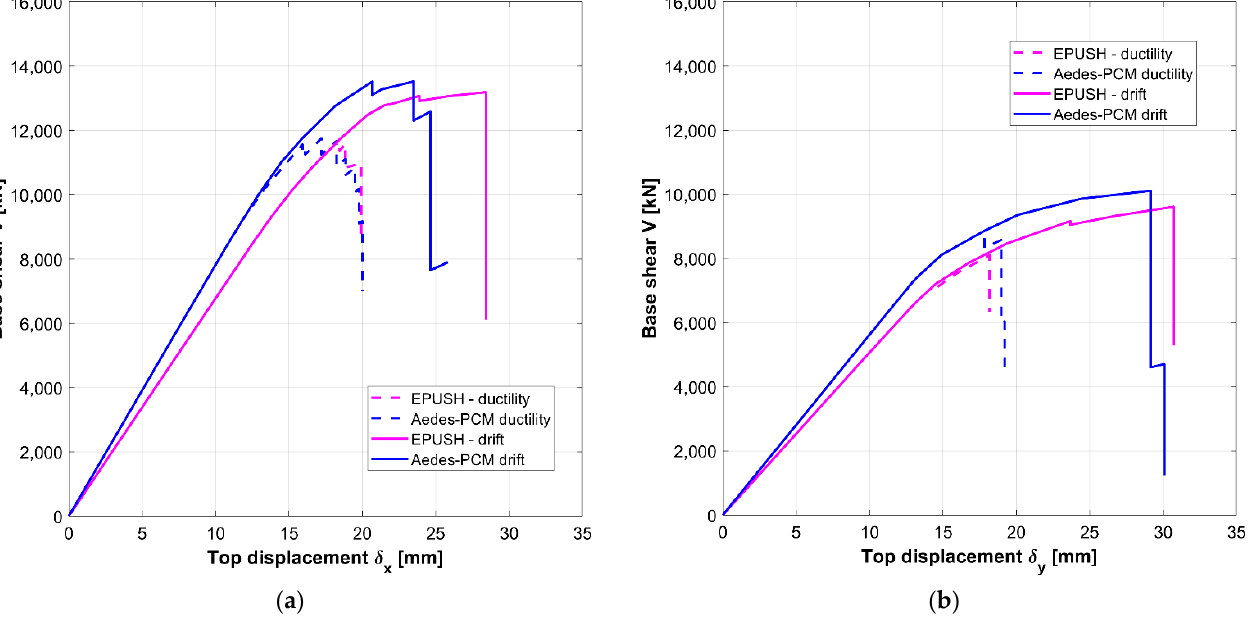
Figure 15. Comparison of capacity curves obtained by means of the E ‐ PUSH software (in magenta) and Aedes PCM ( a ), x ‐ direction (longitudinal), ( b ) y ‐ direction (transversal). In the diagrams, magenta lines represent E ‐ PUSH results, while blue lines represent Aedes PCM results; the curves obtained adopting the drift failure criterion are drawn by solid lines, whereas dashed lines refer to curves computed using the ductility failure cri ‐